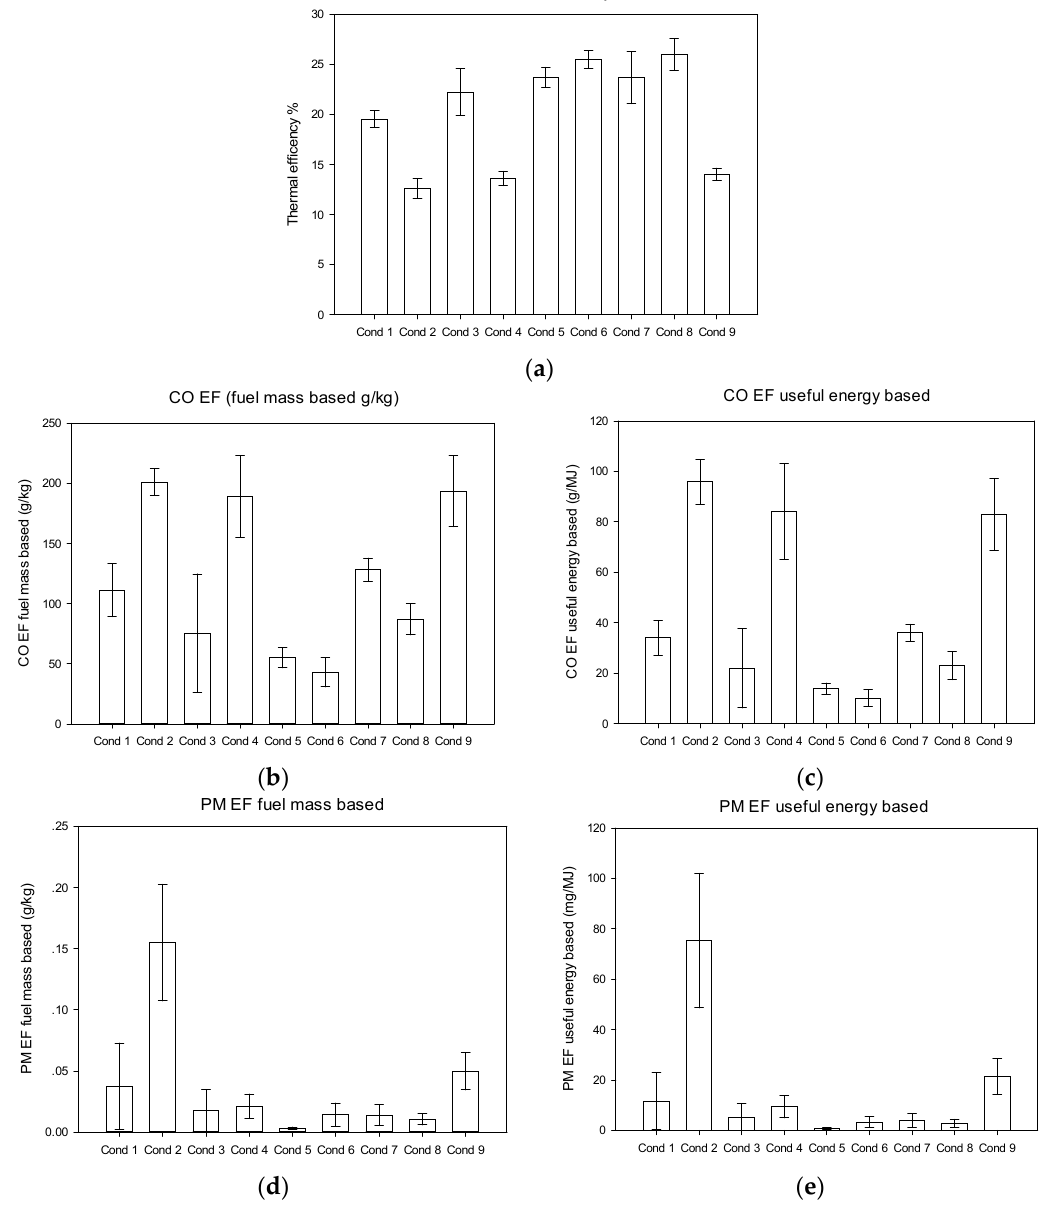
Figure 3. The average performance indicators of different conditions (( a ) thermal efficacy; ( b ) fuel mass-based CO EF; ( c ) useful energy-based CO EF; ( d ) fuel mass-based PM EF; ( e ) useful energy-based PM EF) Cond 1 to Cond 9 were the same conditions as shown in Table 3.